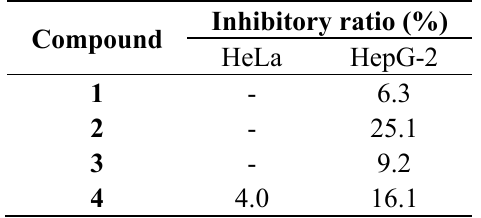
Table 4. Biological Activities of Compounds 1 – 4